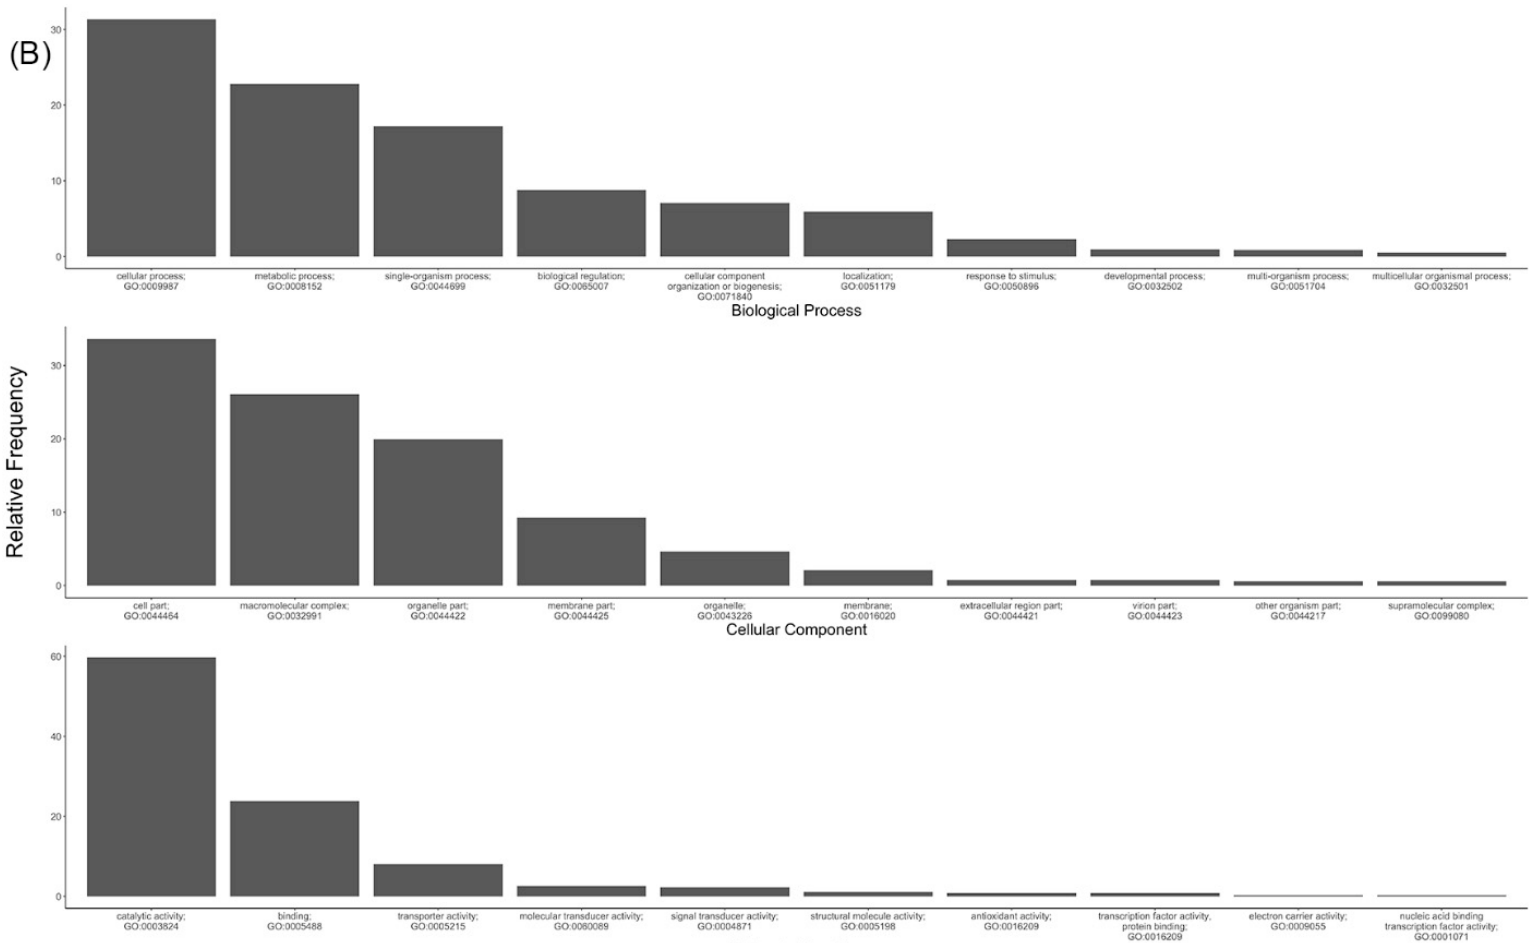
Figure 3. Ten most common Gene Ontology (GO) molecular function, cellular component and biological process categories of S. invicta transcripts: ( A ) full ontology, ( B ) slim ontology.